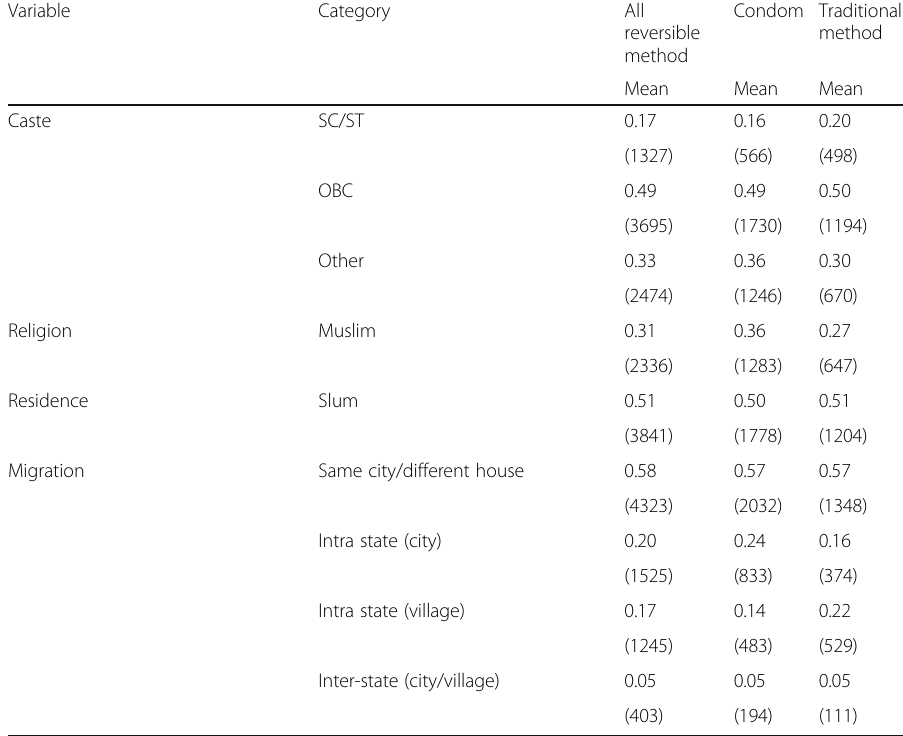
Table 1 Descriptive statistics of the sample variables included in the study (Continued)